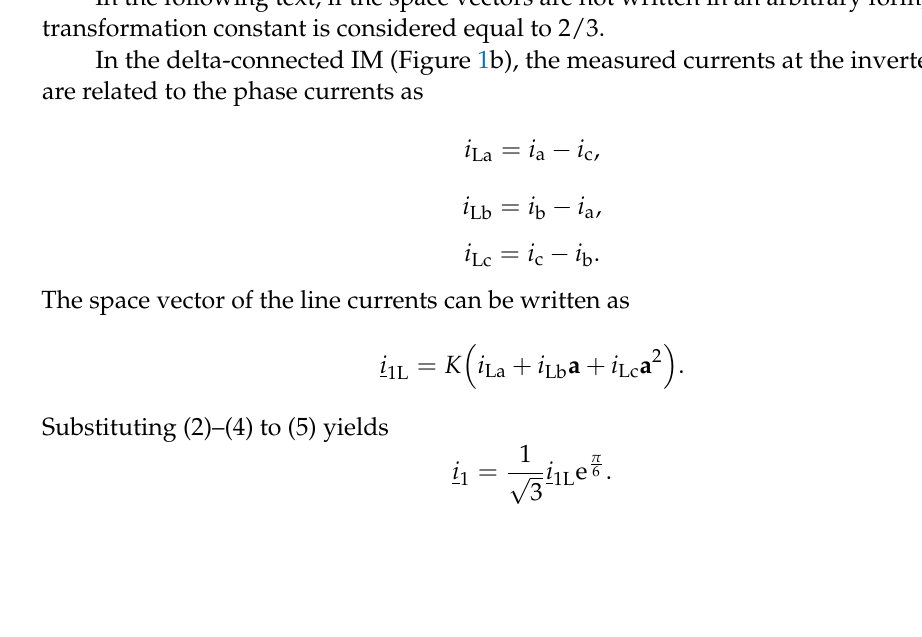
Figure 2. Inverter supplying a delta-connected machine.